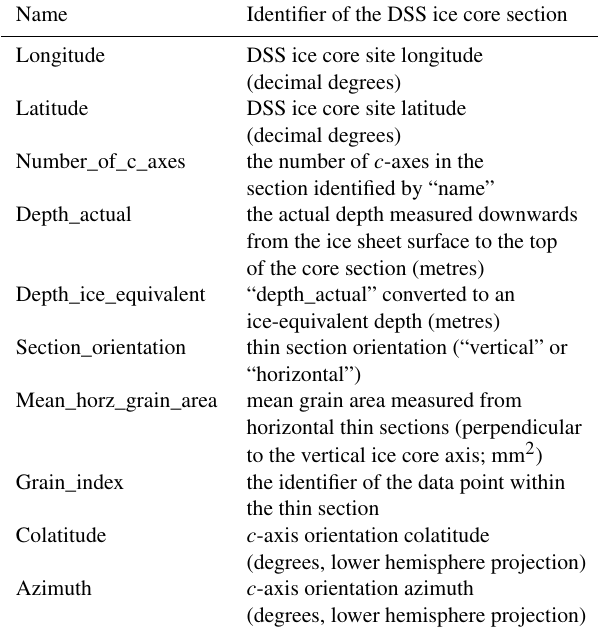
Table 2. Description of the data fields in each row of the csv for- matted DSS ice core c -axis orientation and mean grain area data file, DSS_fabric_data.csv